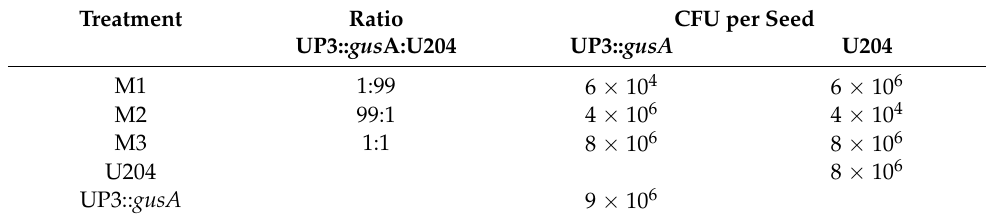
Table 2. Rhizobial mixtures used in nodulation competitiveness Tests